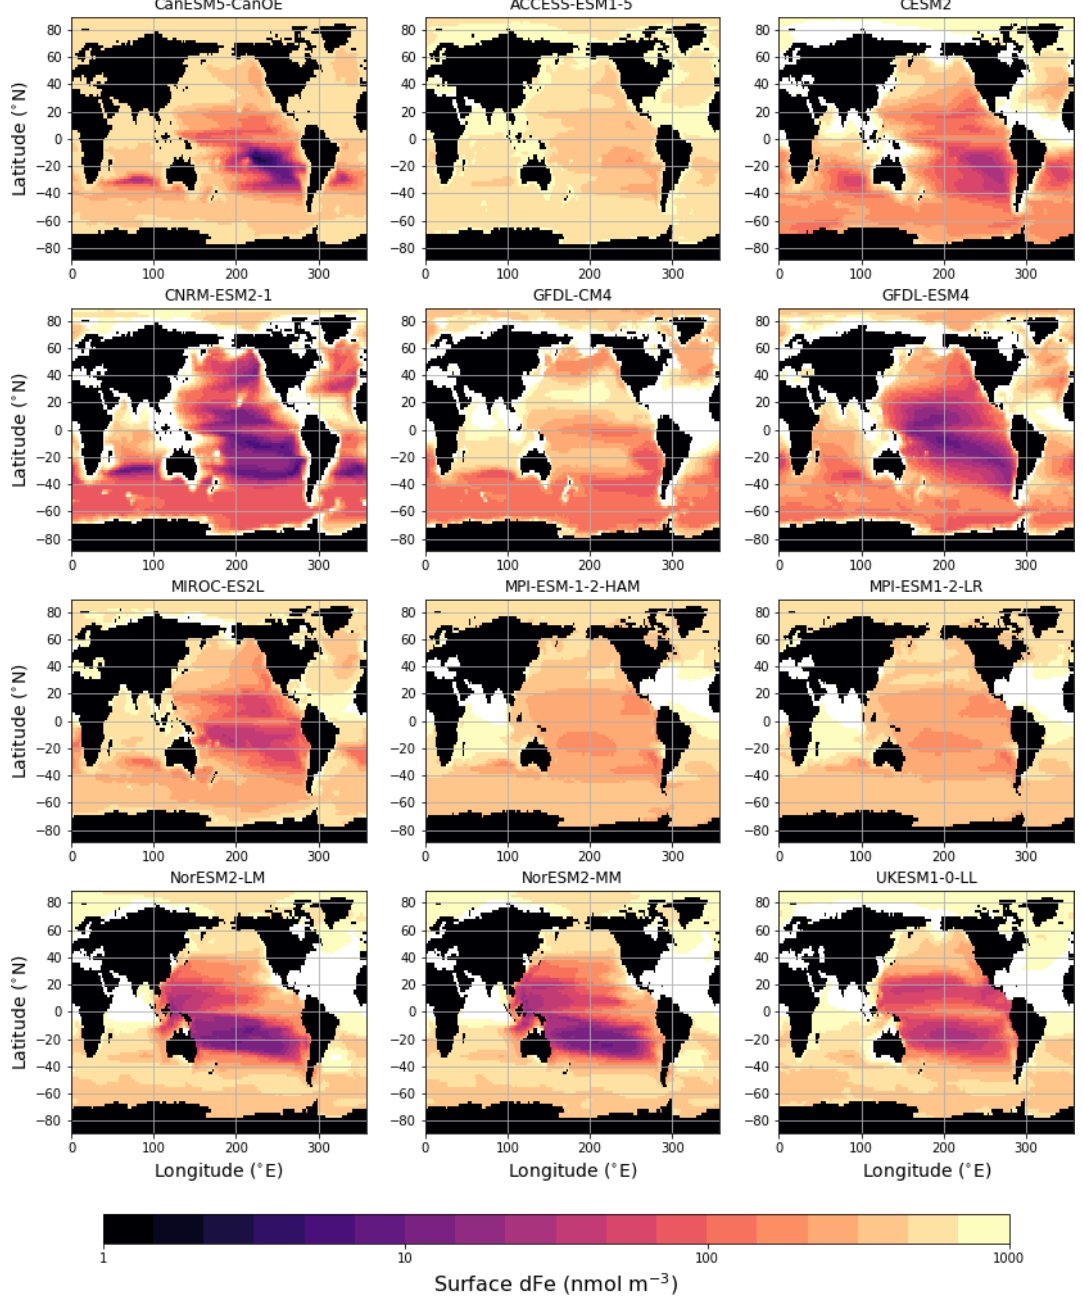
Figure 12. Global distribution of dissolved iron (dFe) concentration (nmolm − 3 ) at the ocean surface for CanESM5-CanOE and other CMIP6 models that published this field. Concentrations exceeding 1000nmolm − 3 are masked in white. CanESM5 is not included because it does not have prognostic